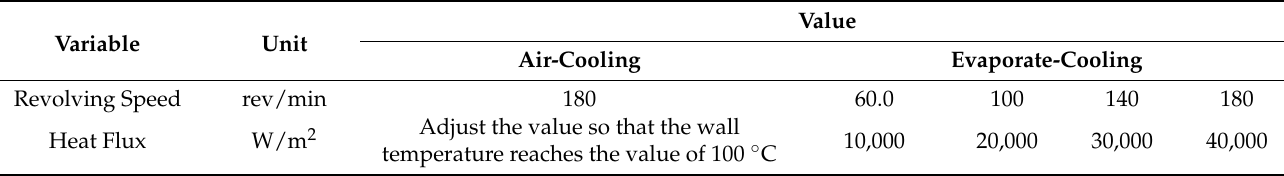
Table 2. The control variables their ranges.